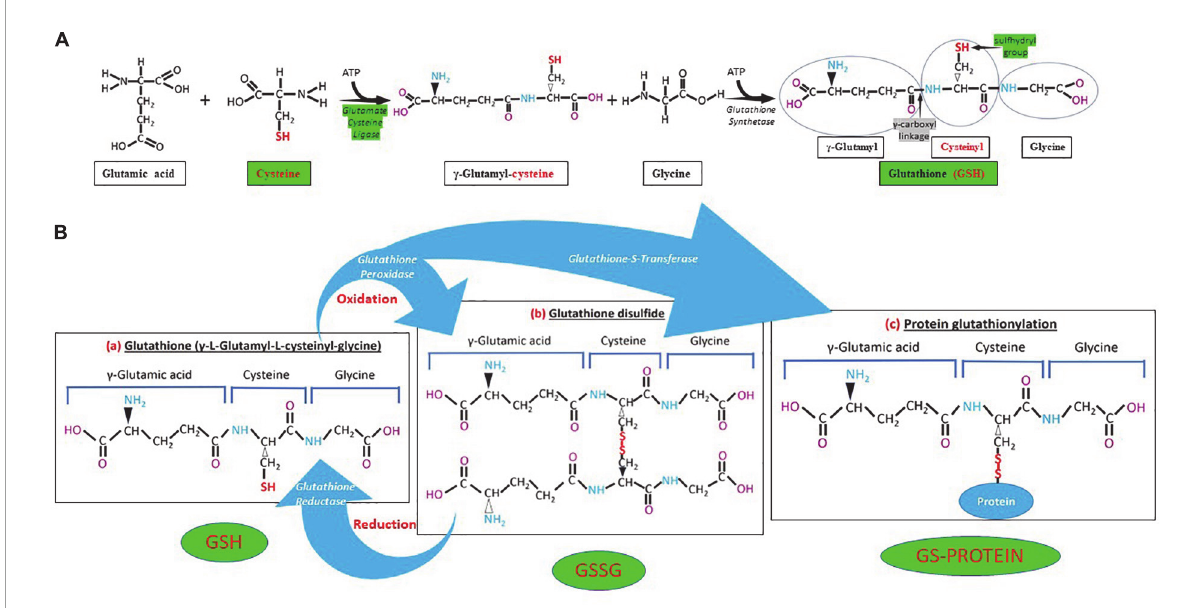
FIGURE1 Glutathione (GSH) synthesis, chemical structure and different forms of GSH. (A) GSH is synthesized in the cytosol in two steps. The first step is the formation of γ -glutamylcysteine from glutamate and cysteine by the enzyme γ -glutamylcysteine synthetase (glutamate cysteine ligase). The second step in GSH synthesis is regulated by glutathione synthetase. Glutathione cysteine ligase and cysteine (green) are the limiting factors in GSH synthesis. The γ -carboxyl linkage (gray) and the sulfhydryl group (green) provide stability and reductive power to the molecule, respectively. (B) Chemical structure of reduced (GSH), oxidized (GSSG) glutathione and GS-protein generated by protein glutathionylation. Glutathione peroxidase oxidizes GSH and glutathione reductase reduces GSSG, while glutathione-S-transferase participates in protein